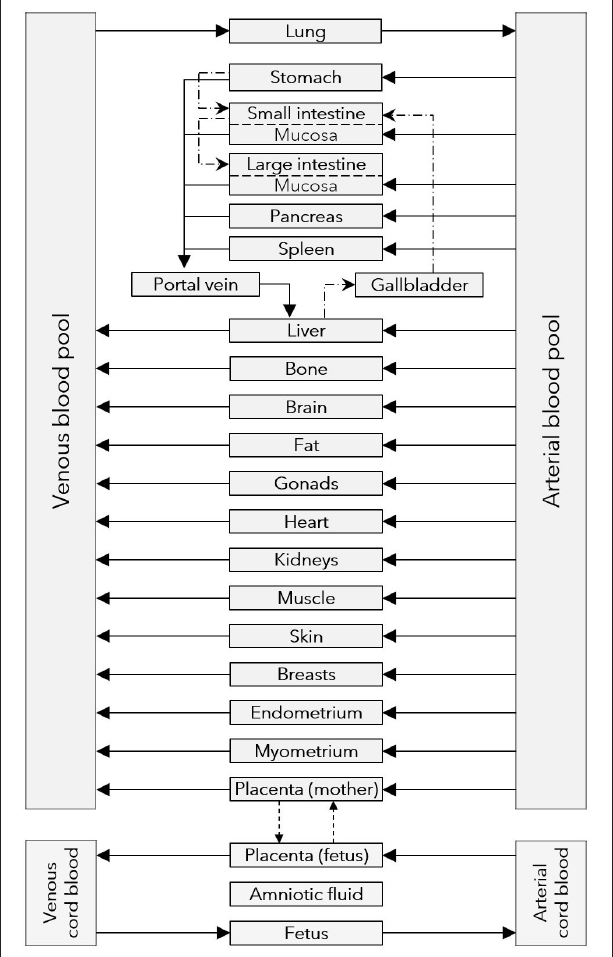
FIGURE 1 | Structure of the pregnancy PBPK models. Gray boxes represent compartments of the PBPK model; solid arrows denote drug transport via the organ blood flow; dashed arrows denote drug transport via passive diffusion; dash dotted lines denote drug transport via gastrointestinal motility or the biliary excretion route. PBPK, physiologically based